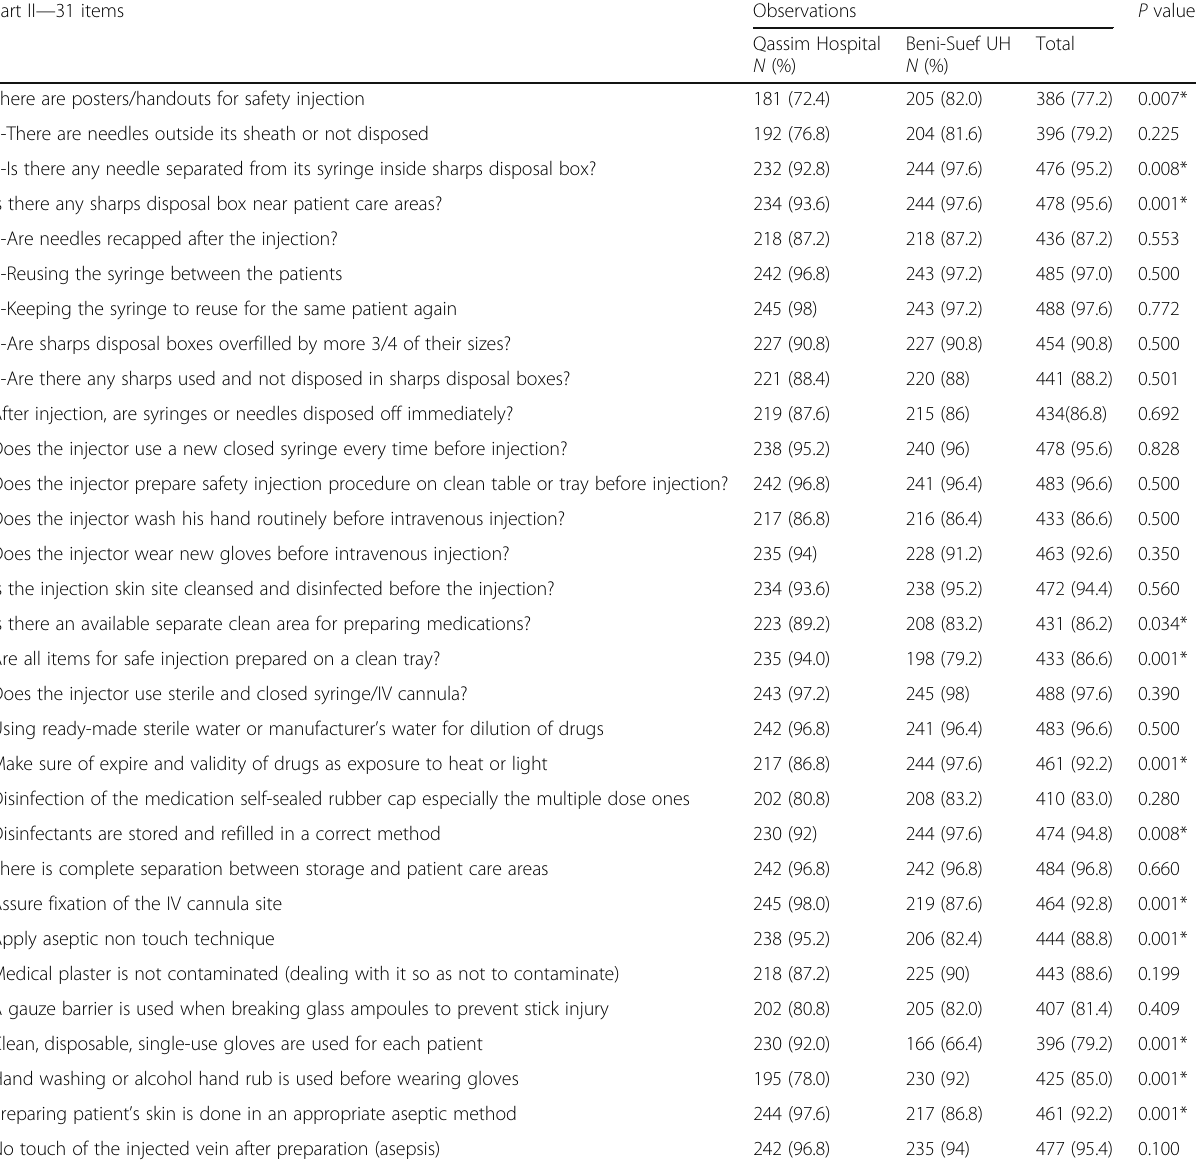
Table 4 Safe injection practices among the nurses in Beni-Suef, Egypt, and Qassim, KSA, 2017 Part II — 31 items